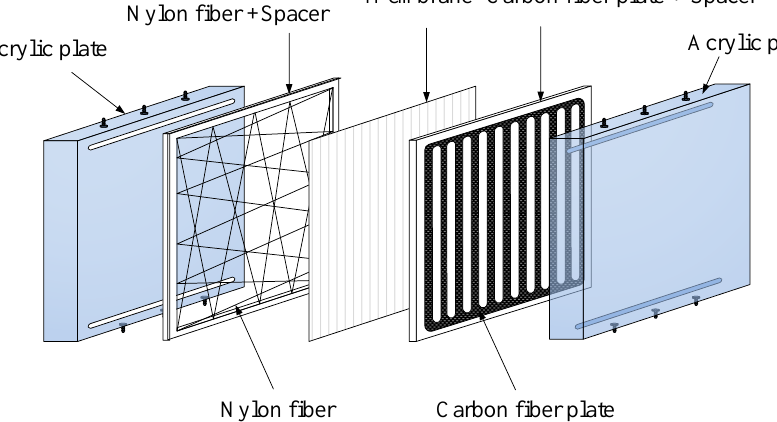
Figure 4. Components of a gas–liquid membrane contactor for the empty channel and the channel with the inserted carbon-fiber spacers.